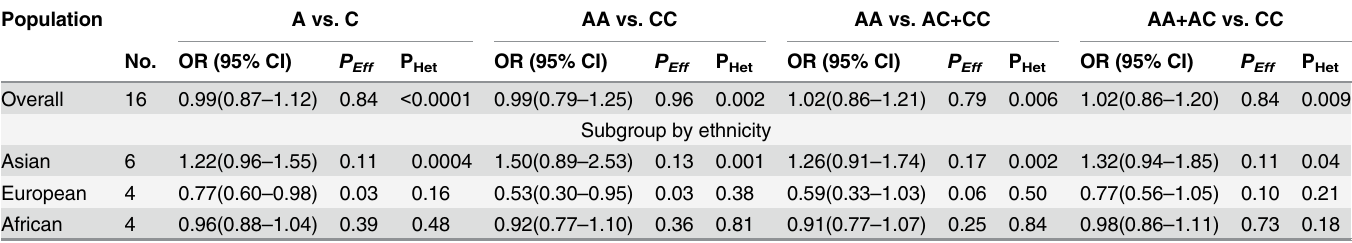
Table 5. Meta-analysis of the association between the IL-10 -592A/C polymorphism and TB. Population A vs. C